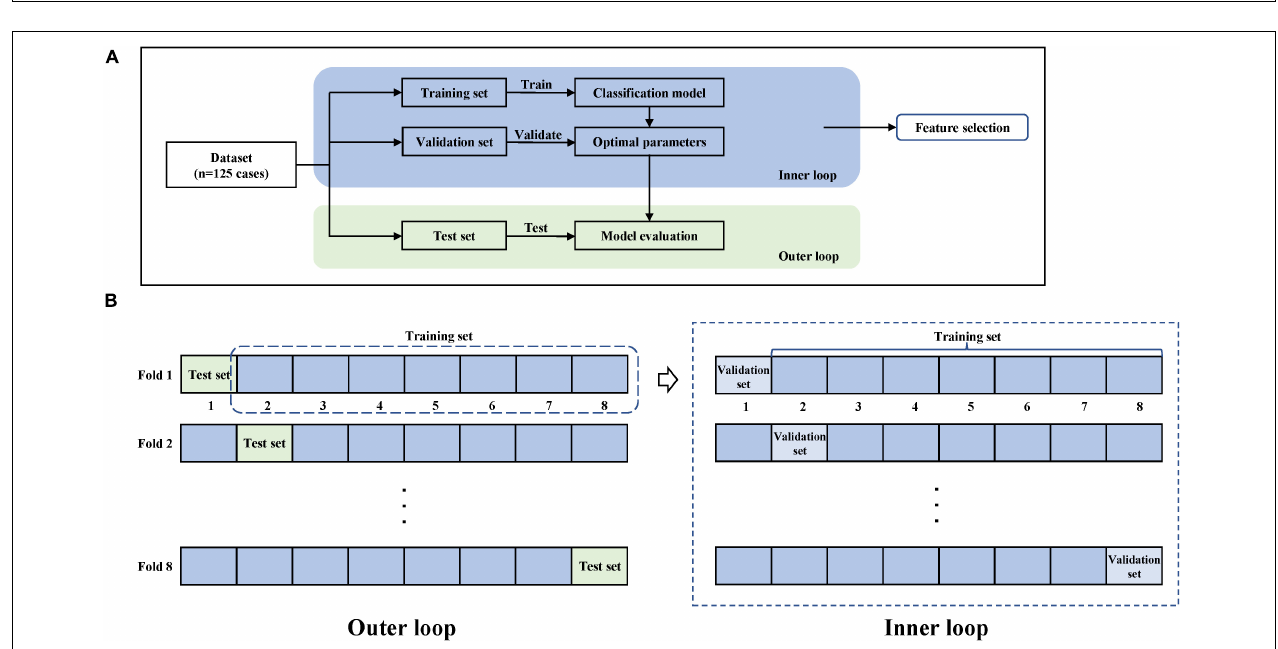
FIGURE 4 | Multidimensional feature set consists of four groups. (A) Morphological features extracted from stereolithography files. (B) Radiomics features extracted from the angiography images and segmentation masks. (C) Deep learning features extracted from the angiography images and segmentation masks. (D) Patient-specific clinical factors.